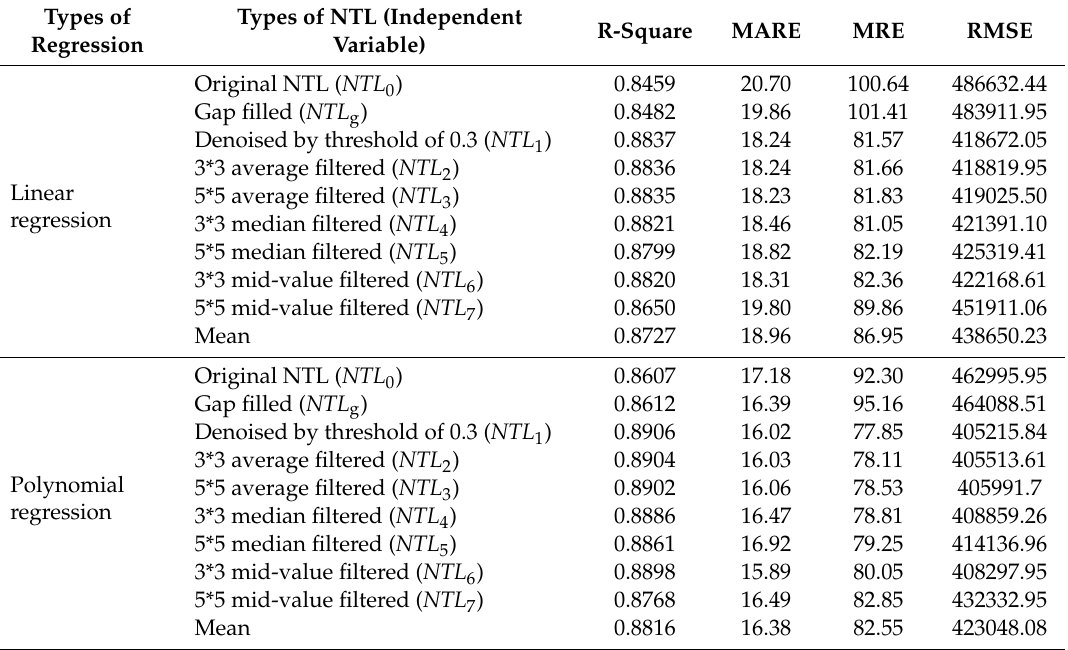
Table 1. Mean regression parameters of 12 months for each